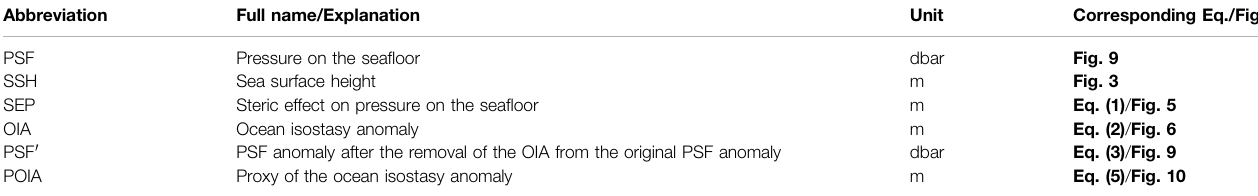
TABLE 1 | Abbreviations, their full names or explanation, units, and corresponding equations and fi gures of the variables used in this